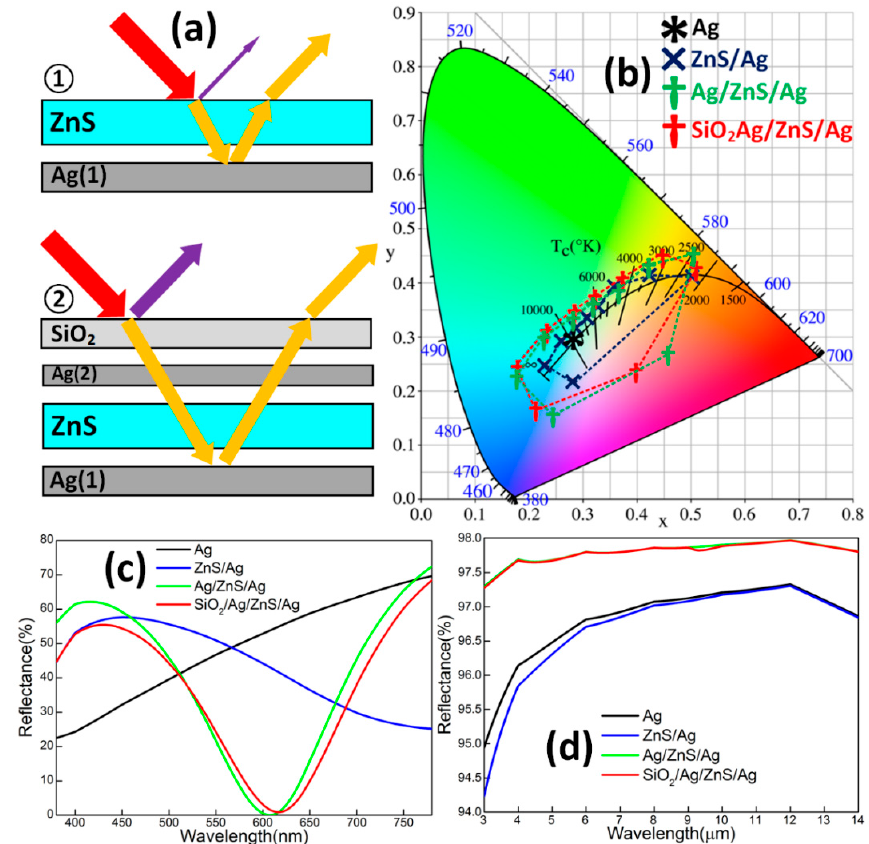
Figure 1. ( a ) The contrasting schematic illustrations of reflections between Ag/ZnS and the designed SiO 2 /Ag/ZnS/Ag. ( b ) The simulated chromaticity coordinates of different structures from 10 nm to 90 nm (interval: 10 nm). The reflection spectrum of different structures at ( c ) visible-light 380–780 nm and ( d ) infrared 3–14 μ m corresponding to d ZnS = 60 nm.